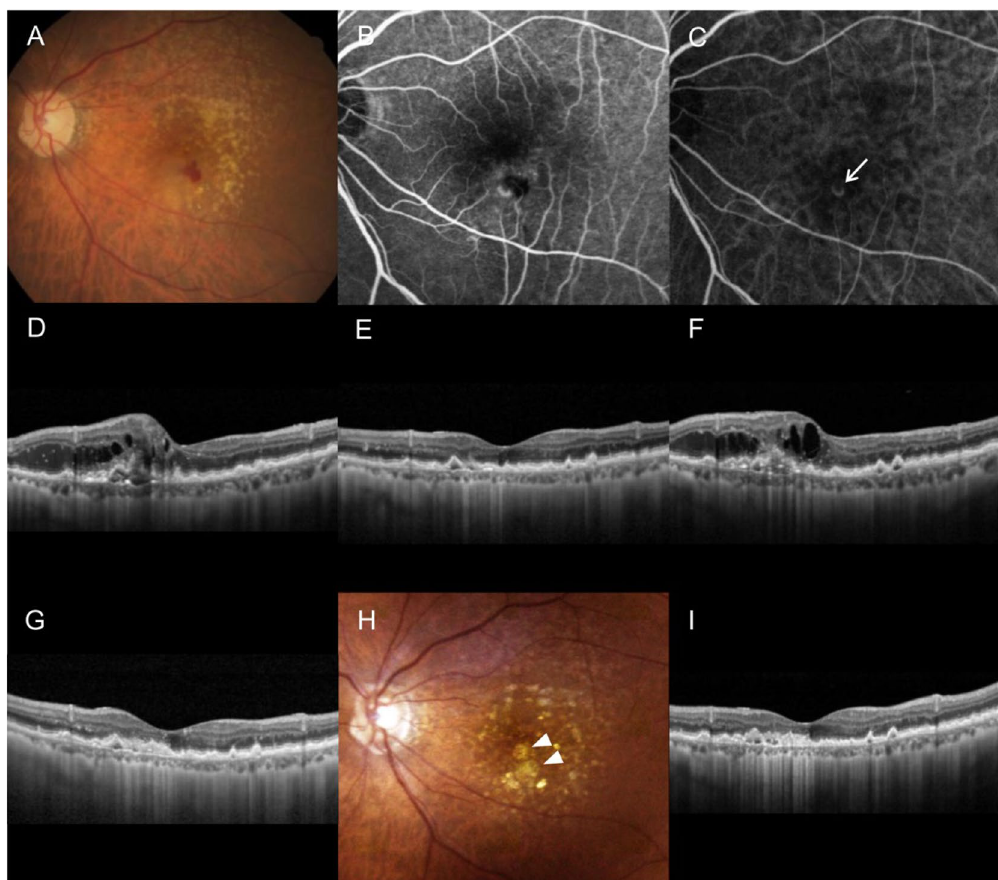
Figure 2. A representative case showing the clinical course of a patient in the treat-and-extend (TAE) group. An 80-year-old patient diagnosed with type 3 macular neovascularization (MNV) ( A – D ). The best-corrected visual acuity (BCVA) is 20/100. After three monthly ranibizumab injections, retinal edema completely resolved ( E ). Seven months after the last injection, lesion reactivation is noted ( F ) and the treatment method was switched to the TAE regimen. The retinal edema is once again completely resolved after the fourth injection ( G ). During the 24 month follow-up period, 14 ranibizumab injections were performed. At 24 months ( H , I ), there is no lesion reactivation and the BCVA is 20/50. On fundus photography, retinal pigment epithelial atrophy is noted (( H) , arrowheads). ( A , H) = fundus photography; ( B) = fluorescein angiography; ( C) = indocyanine green angiography; ( D - G) , ( I) = optical coherence tomography. The arrow in panel ( C) indicates a type 3 MNV